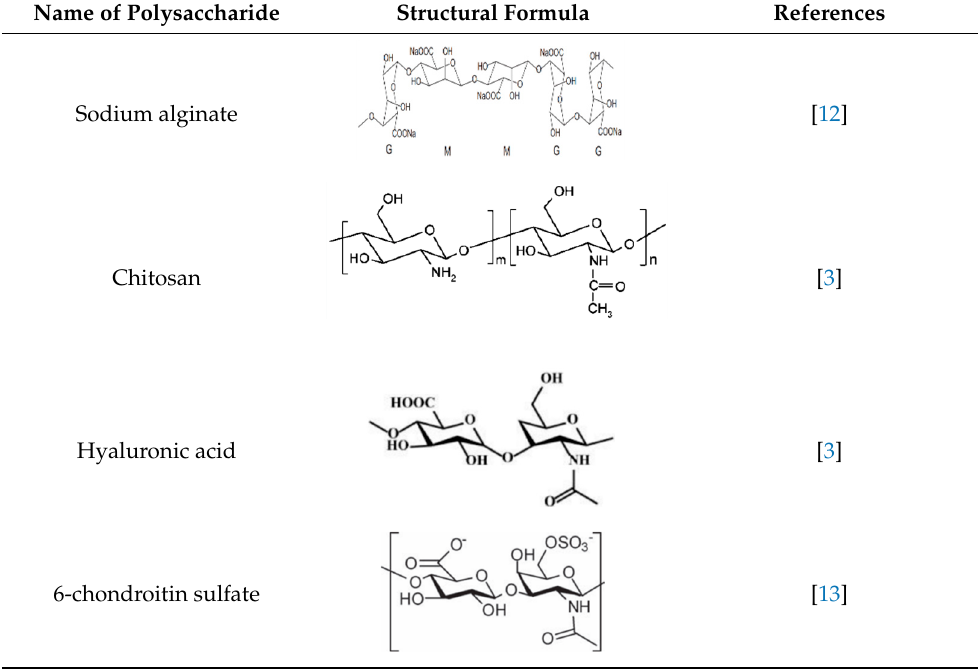
Table 1. Structural formula of polysaccharides.